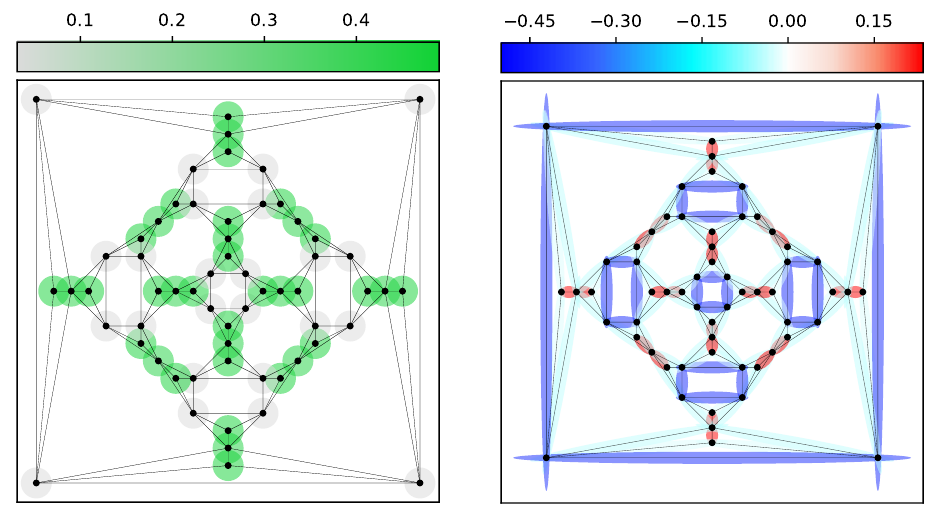
= 18 that corresponds to the 3 / 5 tot 〉 and the nearest-neighbour i